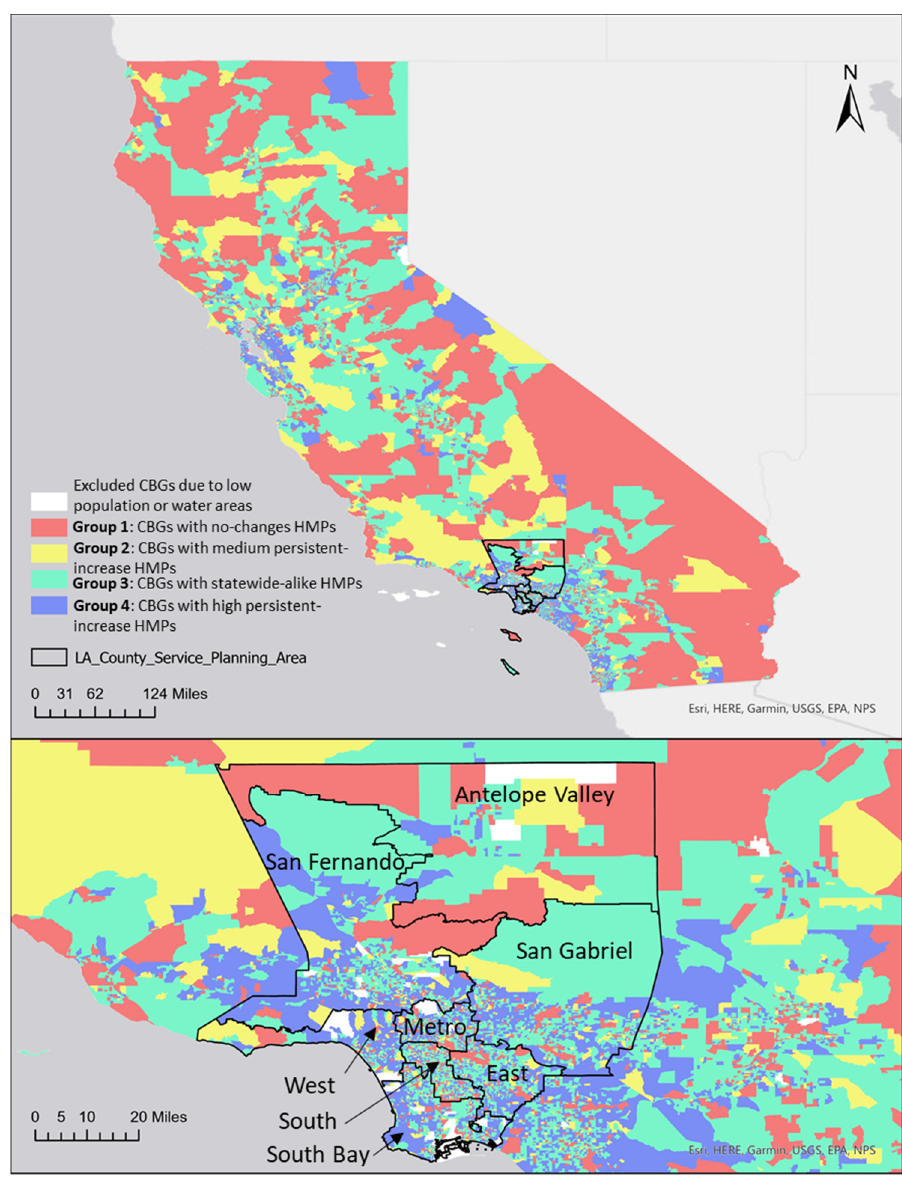
Figure 2. Geographical locations of the CBGs in each median home dwelling time cluster of the whole CA state with an inset view of the SPAs of LA county.